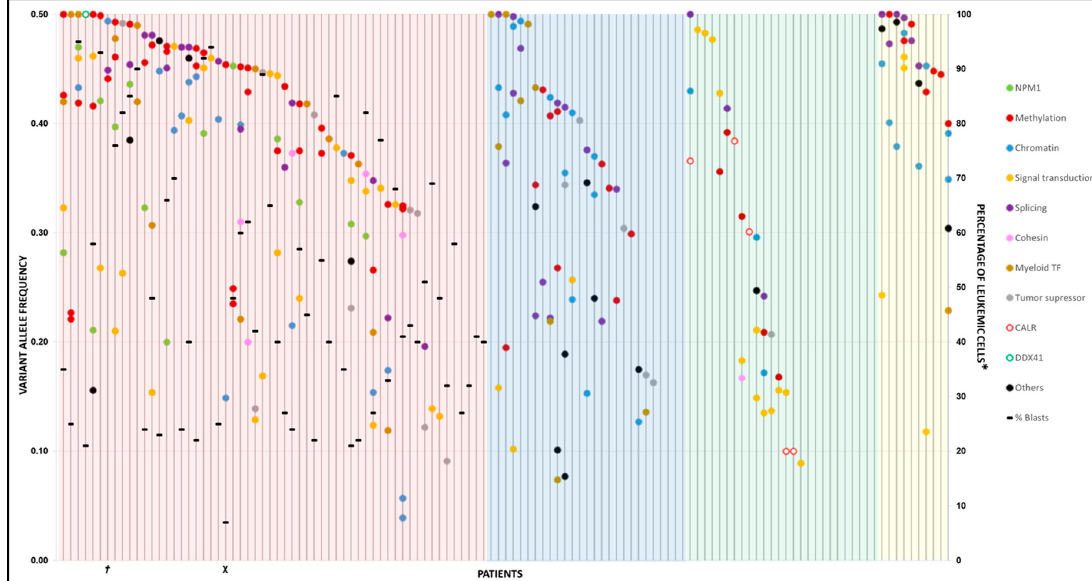
Figure 4. Variant spectrum of 121 myeloid neoplasms (MN) diagnosis samples. Each column represents a patient. Colored circles represent variants in genes classified by functional group and their corresponding VAF from 0 to 0.5. The background color represents the type of MN: acute myeloid leukemia (AML) (red), MDS (blue), MPN (green) and MDS/MPN (yellow). VAF was divided in half in case of deletion of the other allele. †: Percentage of leukemic cells not available. χ : Peripheral blood sample. * Only in AML cases.